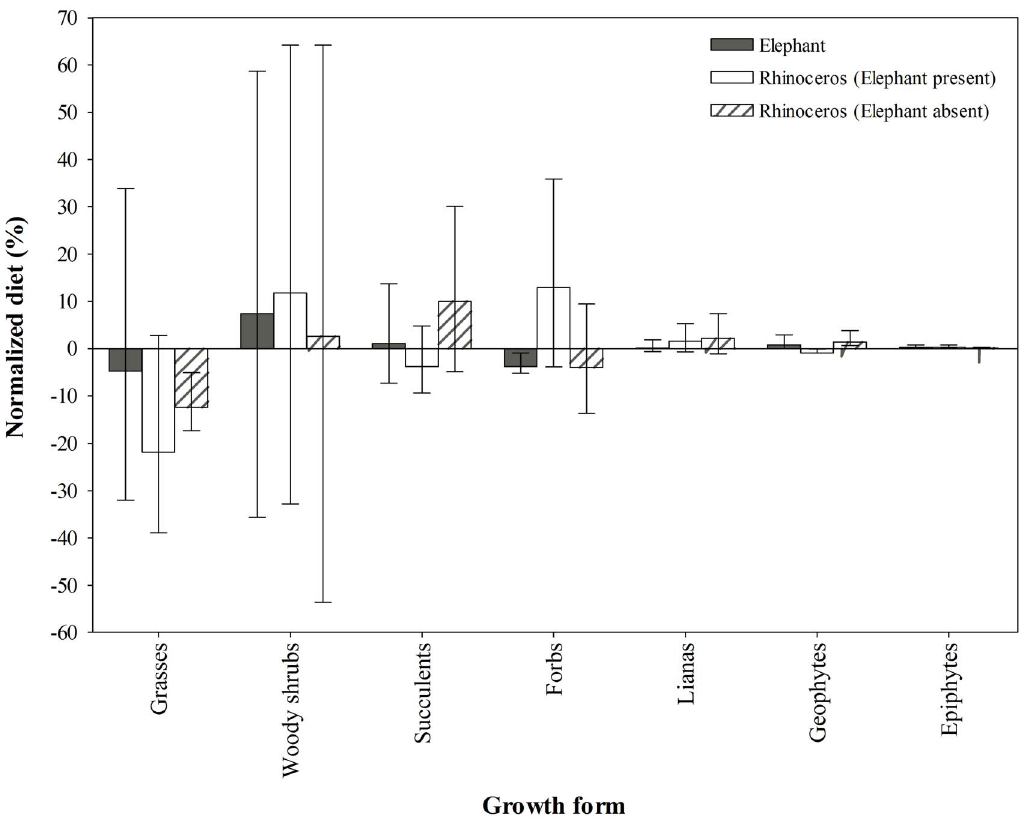
Figure 3. Normalized diet, grouped into broad growth form categories (mean ± 95% confidence interval), of elephant and black rhinoceros in the Addo Elephant National Park. Positive values (i.e. use . availability) with lower confidence limits greater than zero indicate preference; negative values (use , availability) indicate avoidance; at zero, use=availability.